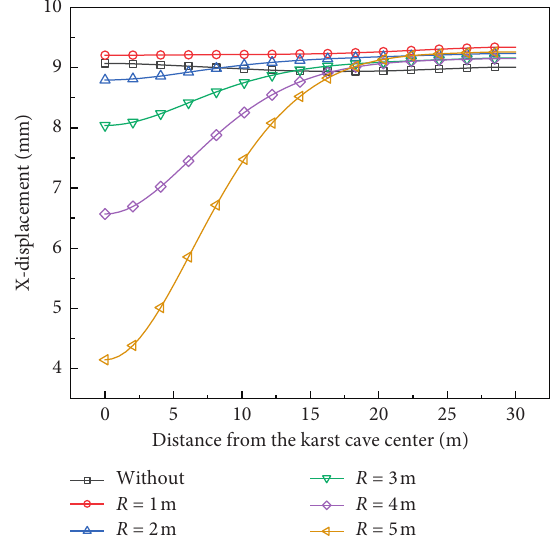
Figure 9: X -displacement curves of the tunnel waist with varying sizes of the karst cave.